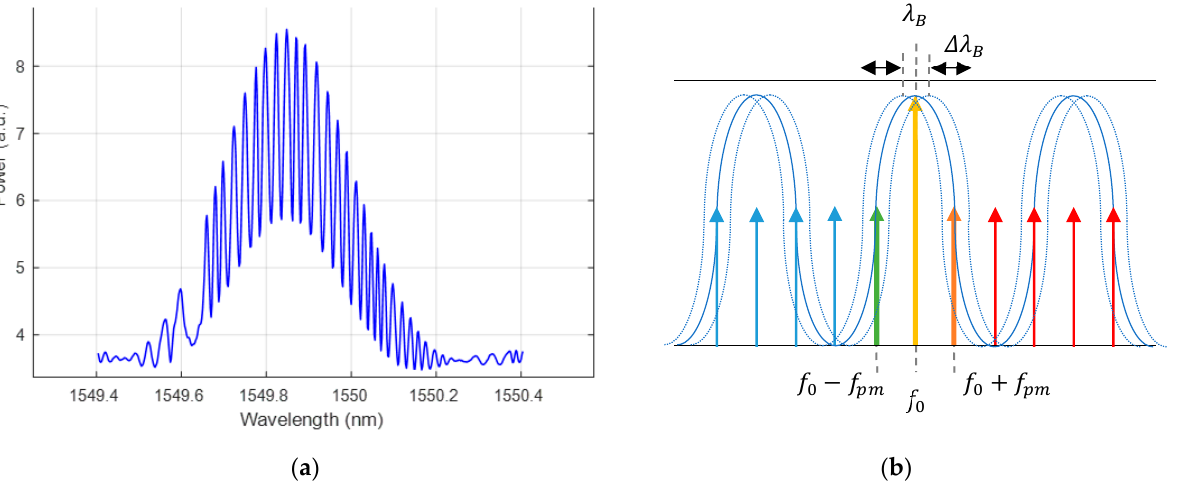
Figure 5. Principle of measurement based on a multiheterodyne dispersion interferometer to interrogate an FBG: ( a ) example of photo-detected output of a dispersion interferometer with an FBG obtained with a SLED and an optical spectrum analyzer (OSA); ( b ) sampling of specific wavelengths with a DOFC for an optical phase read-out.